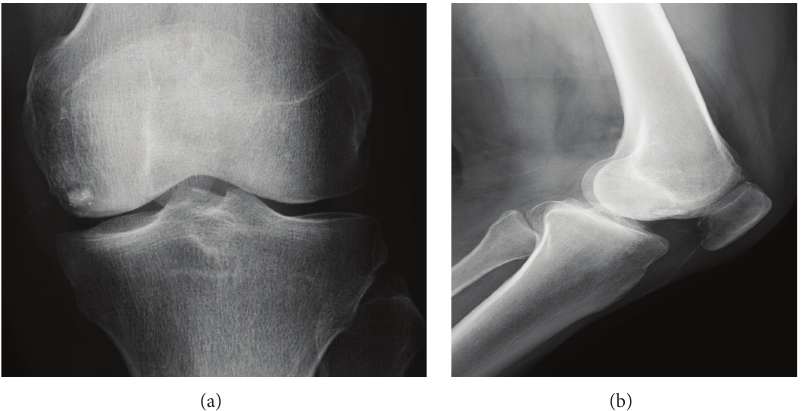
Figure 1: X-rays in AP (a) and profile (b) showing intraosseous metallic body in the medial femoral condyle of the left knee.